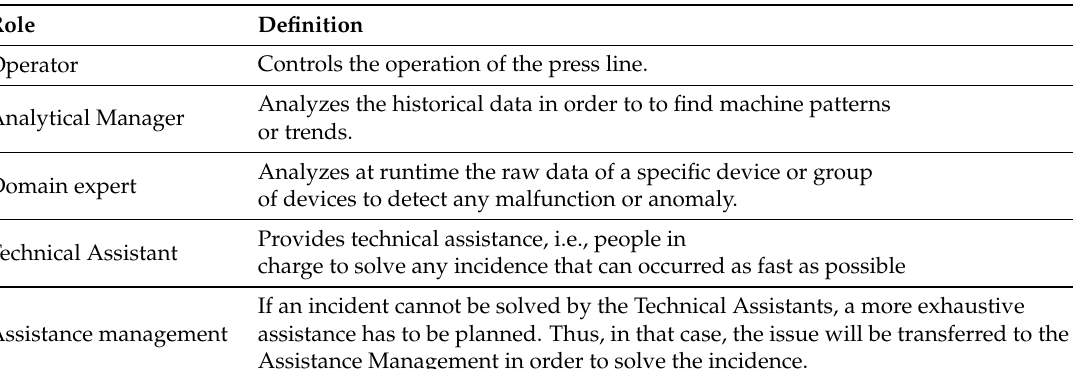
Table 2. The user roles for press line